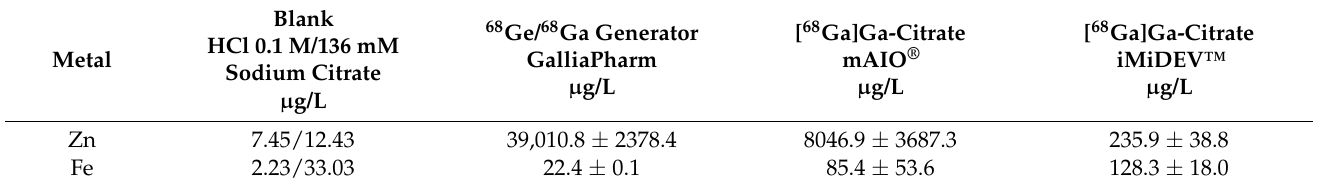
Table 5. Summary of concentrations of the metallic impurities of the 68 Ge/ 68 Ga generator and in the [ 68 Ga]Ga-citrate samples atomic absorption data ( n = [ 68 Ga]Ga-citrate samples atomic absorption data ( n = 2).